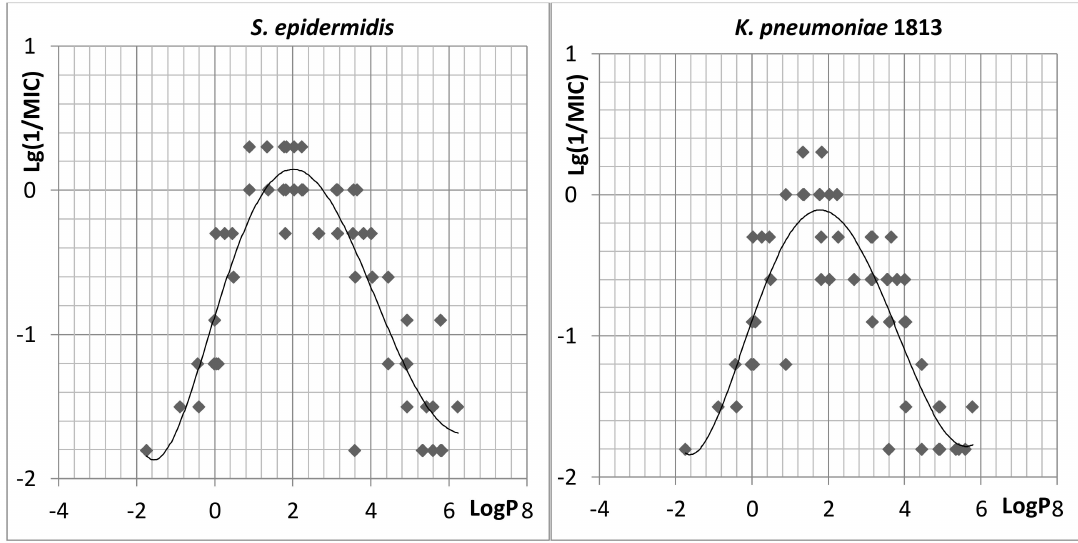
Figure 2. Lg1 / MIC versus calculated logP relationship for novel bis-ammonium salts of pyridoxine. The parabolic line shows the polynomial approximation by using a second order model. Inactive compounds (MIC > 64 mg / mL) are not